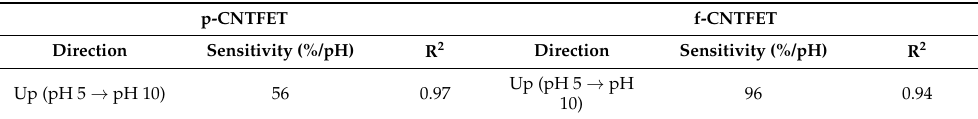
Figure 9. Normalized current values as a function of pH and linear fitting lines of ( left ) p-CNTFET and ( right ) f-CNTFET in borate buffer solution (BBS). Only a single direction from pH 5 to pH 10 was measured. Table 4. Calculated sensitivity of p-CNTFET and f-CNTFET from pH 5 to pH 10 in borate buffer solution (BBS). Only upward direction was considered; 3.4. I–V curves as a function of pH in PBS and BBS.